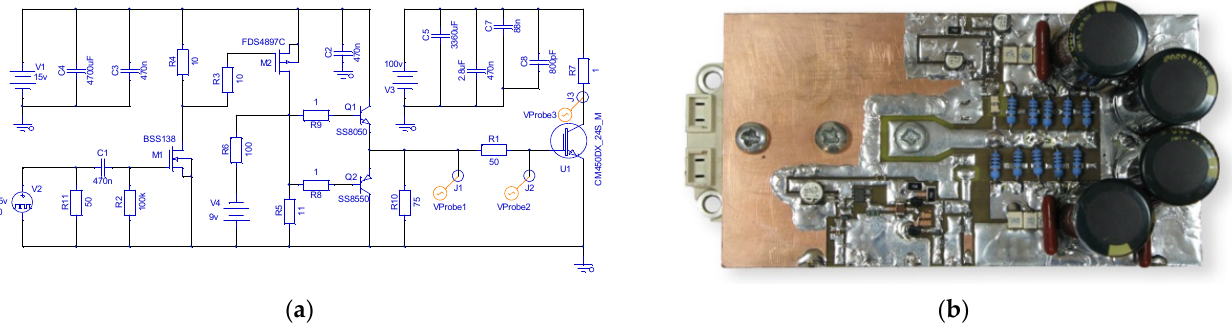
Figure 7. ( a ) Schematic of PCB for measuring IGBT characteristics, ( b ) test-bench PCB designed for SEMIKRON module SKM200GB123D.